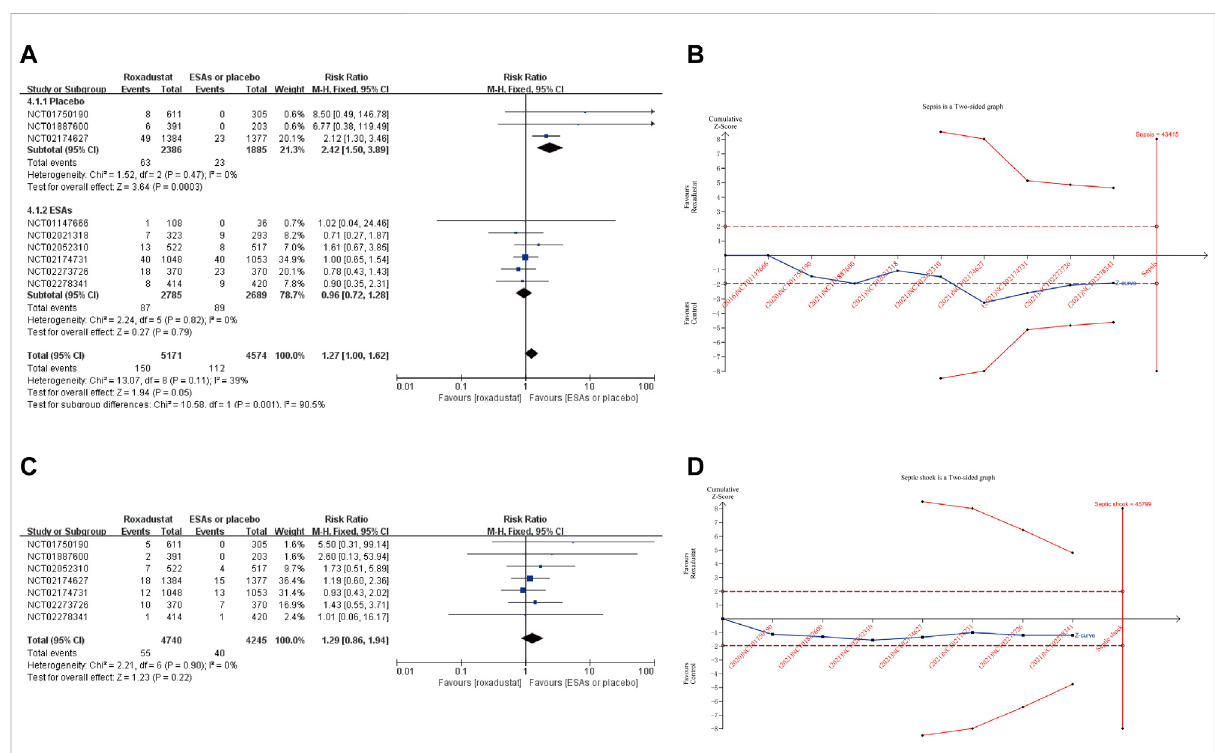
FIGURE 3 Forest plot of sepsis (A) and septic shock (C) . TSA of sepsis (B) and septic shock (D) . Abbreviations: ESAs, erythropoiesis stimulating